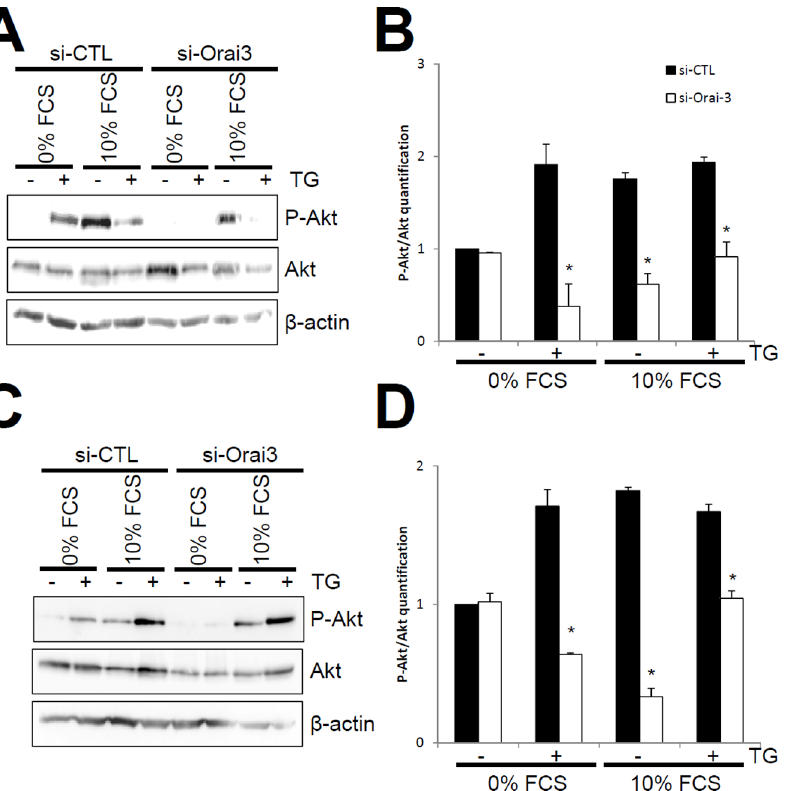
Figure 7. Effect of si-Orai3 on thapsigargin and serum induced AKT phosphorylation. A, B, Representative western blotting of P-Akt and Akt proteins in NCI-H23 (A) and NCI-H460 cells (B) transfected with si-CTL or si-Orai3. Each siRNA was tested in 0% serum (FCS), 0% FCS + 1 m M thapsigargin (TG), 10% FCS, and 10% FCS plus 1 m M TG. The quantification of the ratio P-Akt/Akt in NCI-H23 and NCI-H460 cells using densitometric analyses is shown in C and D (n=2, p , 0.05, One Way Anova on Ranks).